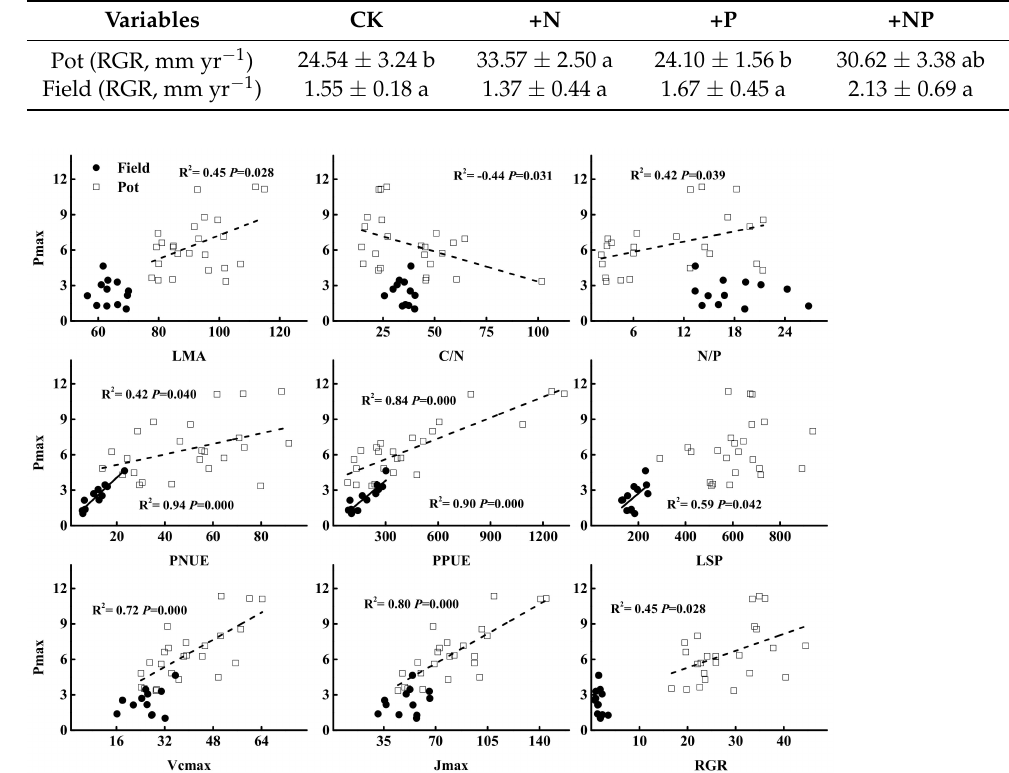
Table 2. Relative growth rates (RGR) of Schima superba under field and pot experimental approaches, respectively treated by N and P addition. Note: The small letters indicate the differences ( p < 0.05) among the four treatments. (CK = control, +N = nitrogen addition, +P = phosphorus addition, +NP = nitrogen plus phosphorus addition).